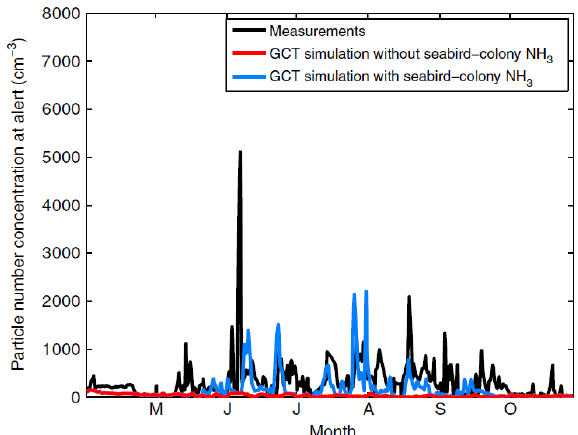
Figure 9. Single-particle mass spectrometry results from the NET- CARE 2014 summer campaign, where the detected particle frac- tion is plotted against the aerodynamic diameter of the particle. The total number of particles detected in a specific size bin is plot- ted in red. The classifications of particle types containing different species are: Na / Cl (dark blue), levoglucosan (grey), Na (green), el- emental carbon (EC, black), and a category of particles called “Sec- ondary” that includes organics, potassium, sulfate, trimethylamine, and MSA (light blue). Figure from Willis et al. (2017).